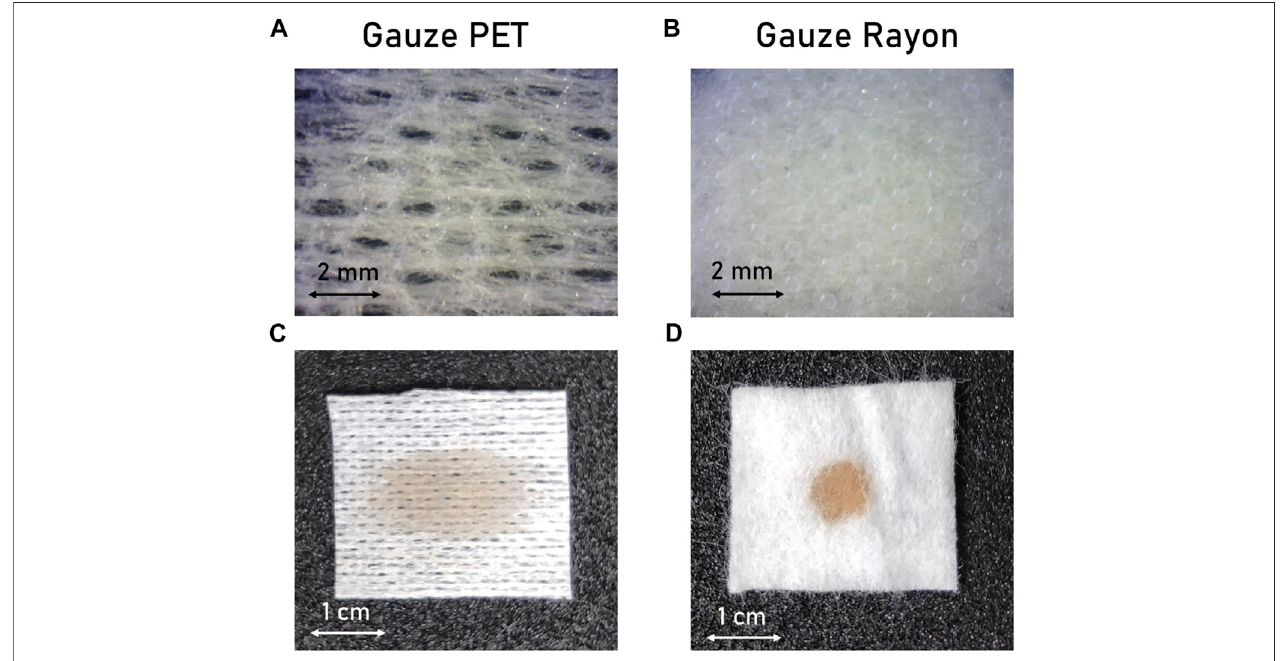
FIGURE 1 | Active gauze textile substrates. (A – B) Enlarged top view and (C – D) top view photos of the active substrates showing the different spreading of a colored liquid through the textile surface of PET and Rayon gauzes.